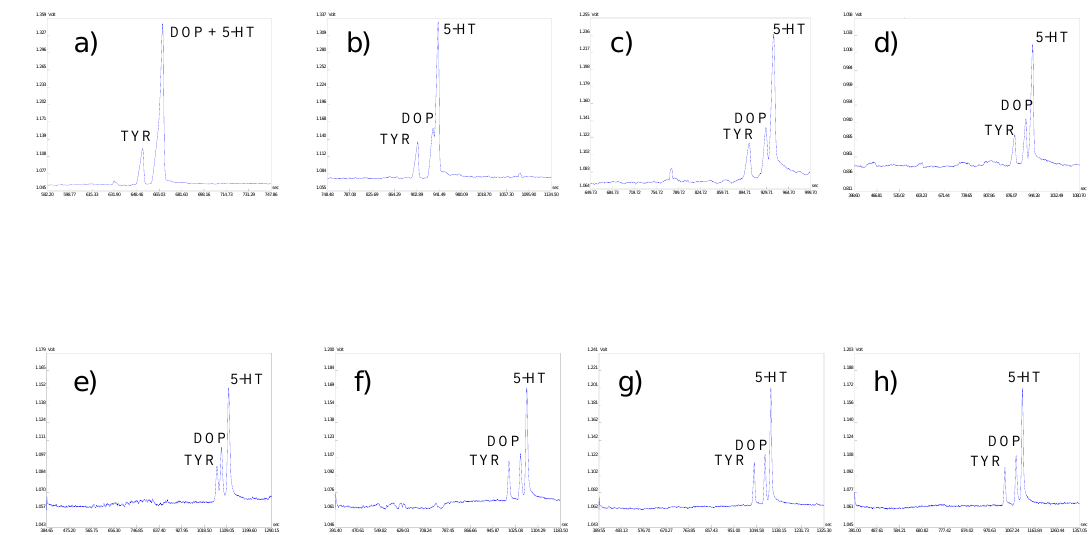
Figure 2. Effect of additives (isopropanol and HP– β –CD) on the CZE separation of mixture of three biogenic amines—5-HT, DOP, and TYR in model water matrix using ITP–CZE–UV experimental arrangement. Concentration levels of the injected hydrochloride salts of 5-HT, DOP, and TYR were 100 ng · mL − 1 for each analyte that represented a 82.86 ng · mL − 1 concentration of 5-HT, a 80.77 ng · mL − 1 concentration of DOP, and a 79.00 ng · mL − 1 concentration of TYR. Tested BGE compositions were following: 25 mM EACA + 50 mM HAc + 0.1% m-HEC ( a ) -, ( b ) + 10% isopropanol, ( c ) + 20% isopropanol, ( d ) + 30% isopropanol, ( e ) + 10 mM HP– β –CD, ( f ) + 10 mM HP– β –CD + 10% isopropanol, ( g ) + 10 mM HP– β –CD + 15% isopropanol, ( h ) + 10 mM HP– β –CD + 20% isopropanol. A 90 mm length of the CZE separation capillary was employed. For other instrumental parameters and optimum ITP separation conditions, see Sections 2.1 and